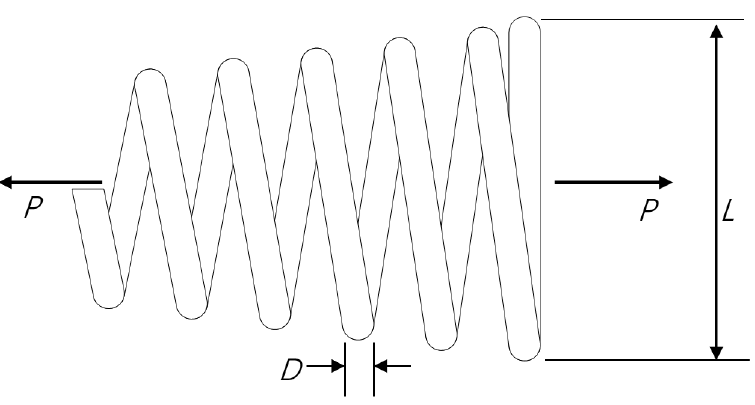
Figure 4. Schematic diagram of tension/compression spring design.